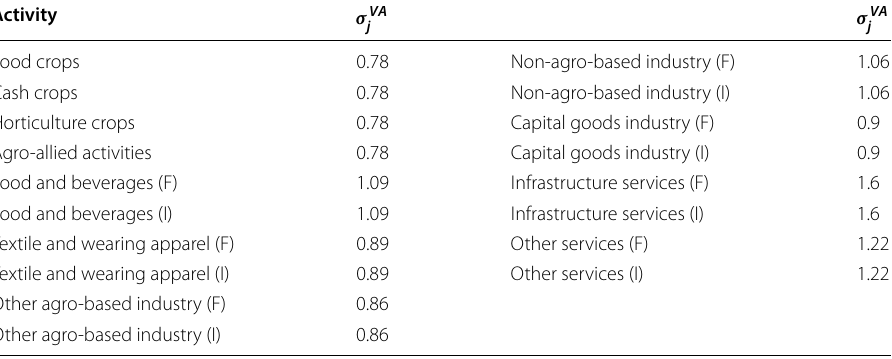
Table 15 CES elasticity of transformation parameter ( σ VA calculation is based on the estimates provided by Pradhan and Sahoo (2008) and Goldar et al. (2013)